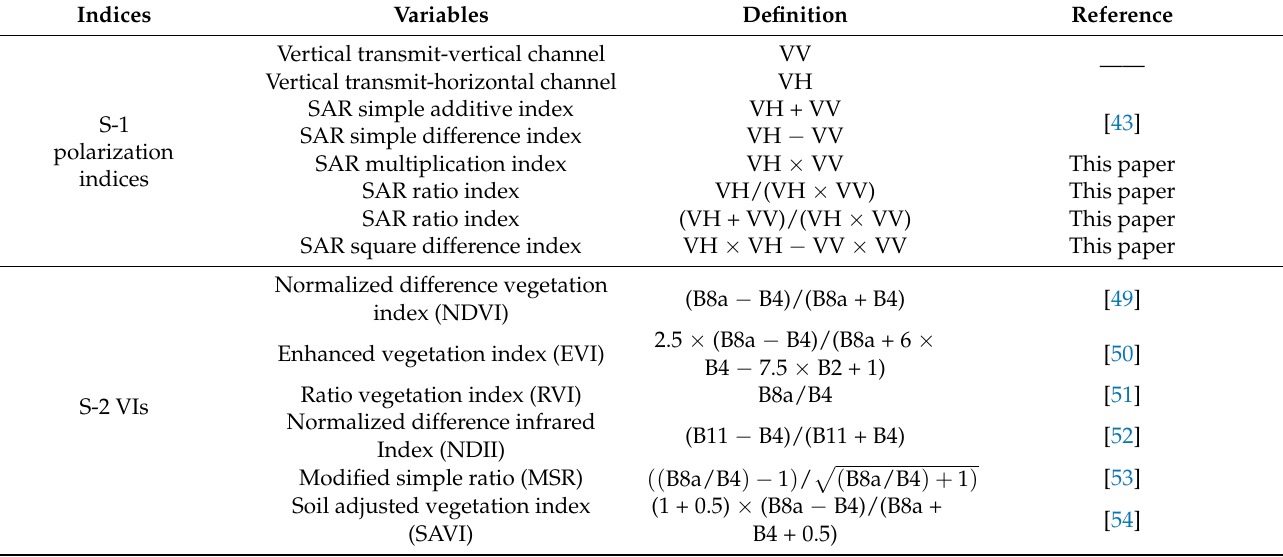
Table 2. List of Sentinel-1 and Sentinel-2 predictors used for maize biomass